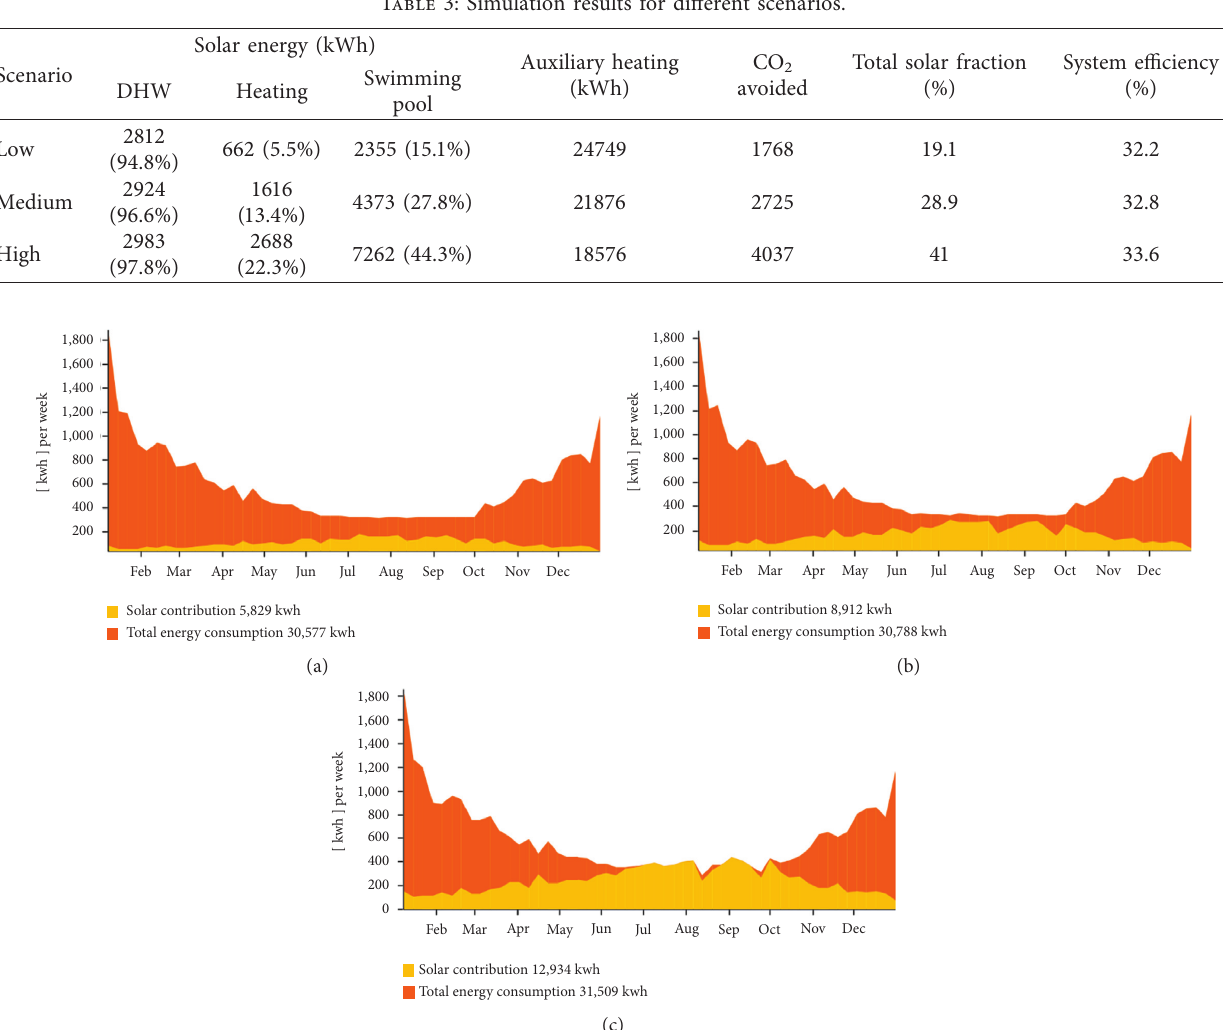
Table 3: Simulation results for different scenarios.